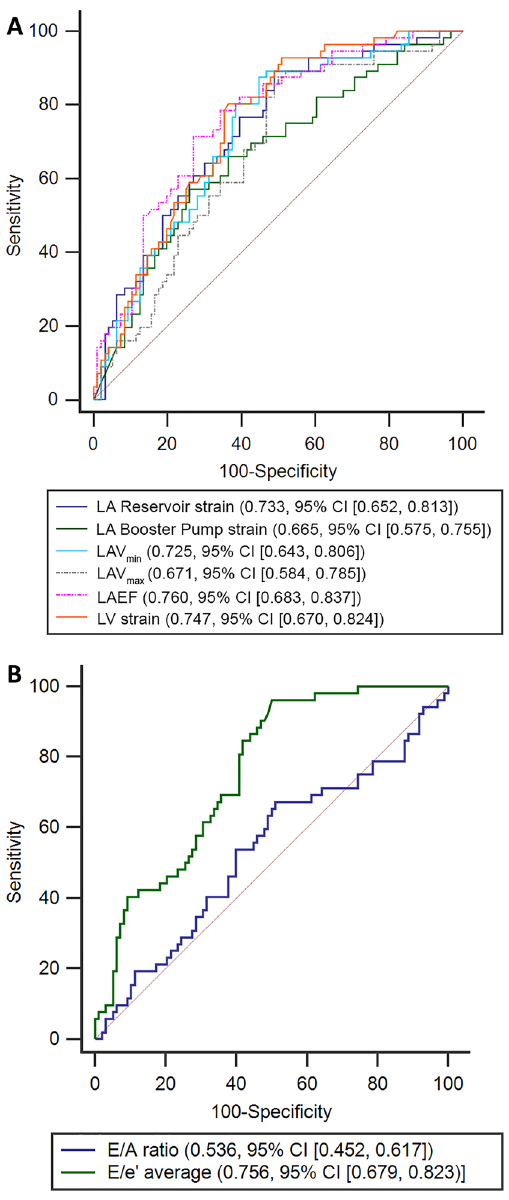
Figure 3. Receiver operating characteristic analyses of left atrial parameters ( A ) for predicting the composite clinical outcome as well as standard echocardiographic parameters for diastolic dysfunction ( B ) for